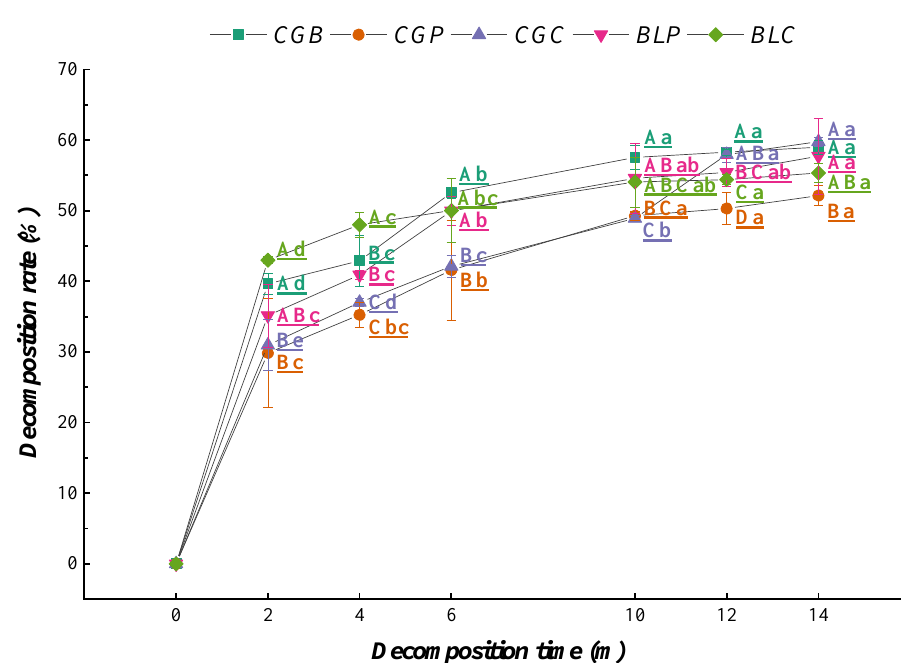
Figure 3. Characteristics of the decomposition rate of leaf litter with decomposition time. Table 2. Regression decomposition model of dry matter mass loss of different leaf litters.